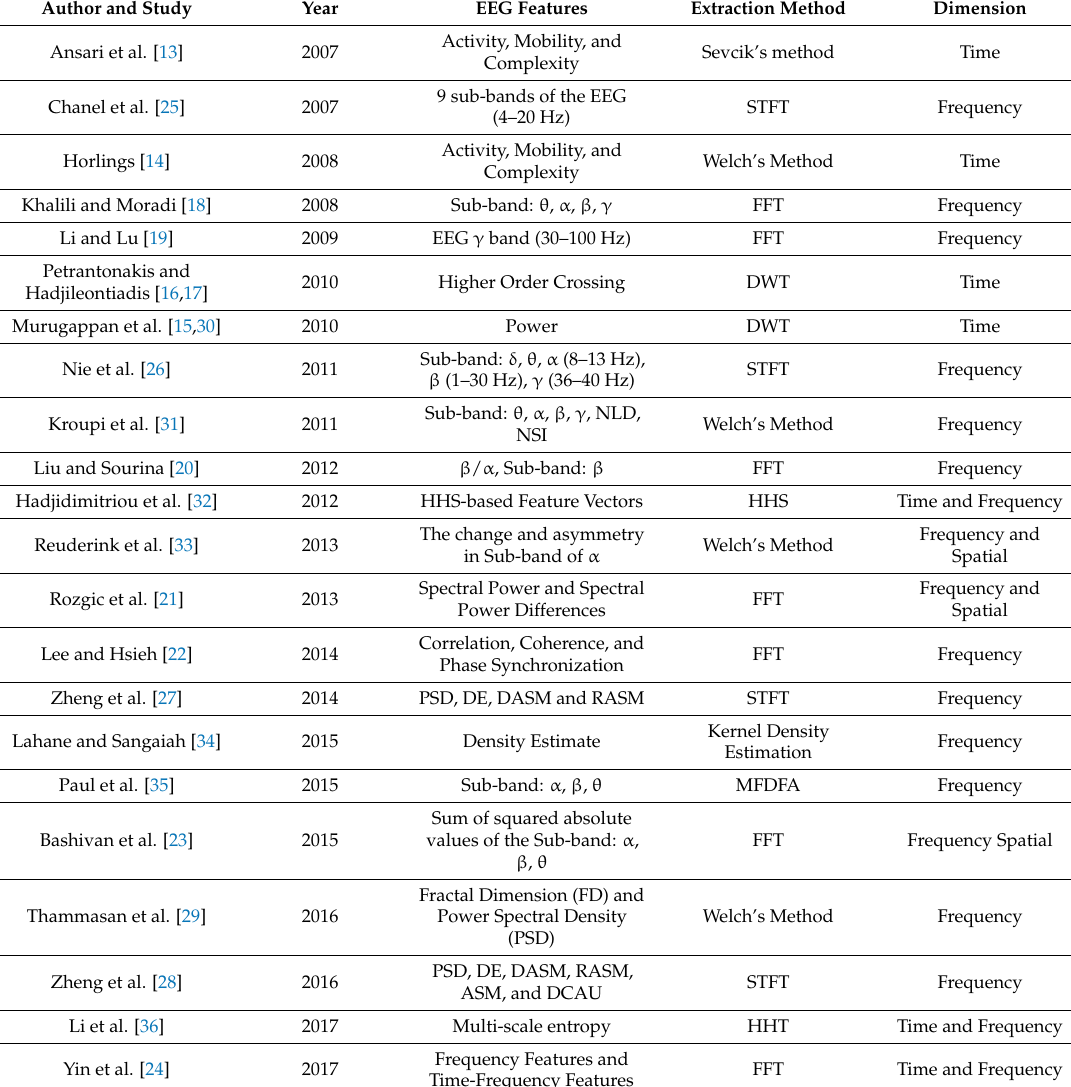
Table 1. A summary of feature extraction for emotion recognition from EEG 1